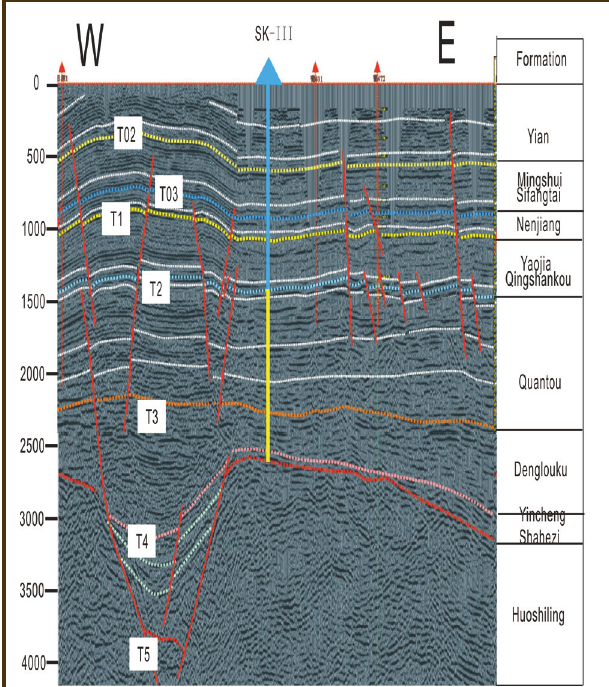
Figure 2. W-E Seismic profile showing the locale of the proposed Songke-III well with stratigraphic interpretation. The vertical blue line indicates the strata to be drilled in rotary mode. The yellow line indi- cates the planned wireline coring section down to the total depth of ~2700 m. This was done in order to avoid structural complications and to penetrate the most complete stratigraphic